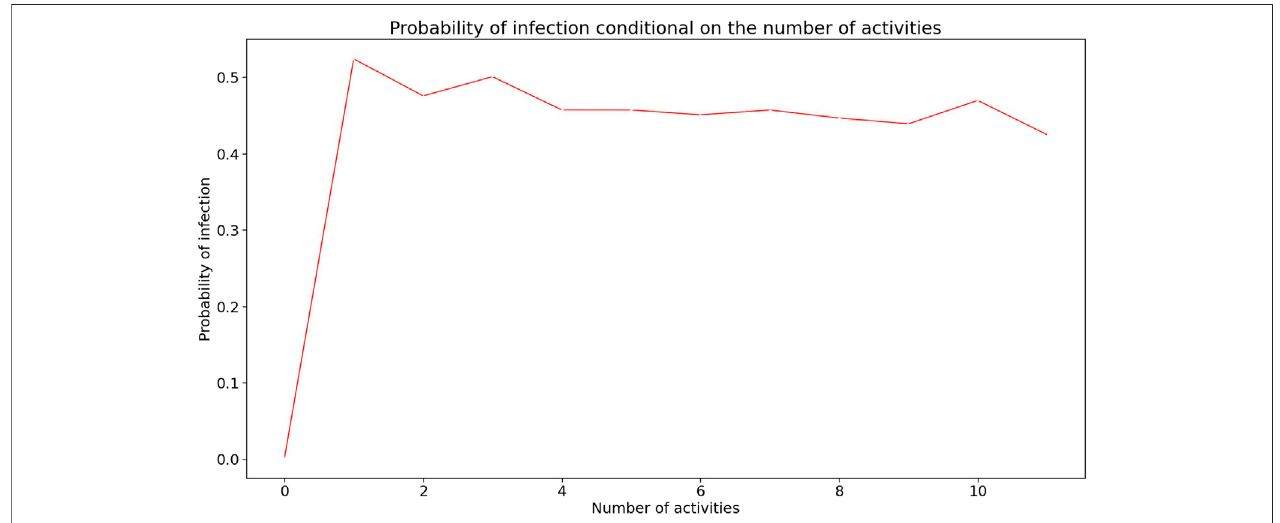
FIGURE 10 | Risk of infection conditional on the number of out-of-home activities in daily plans. Observations with less than 100 records are not included in the analysis.